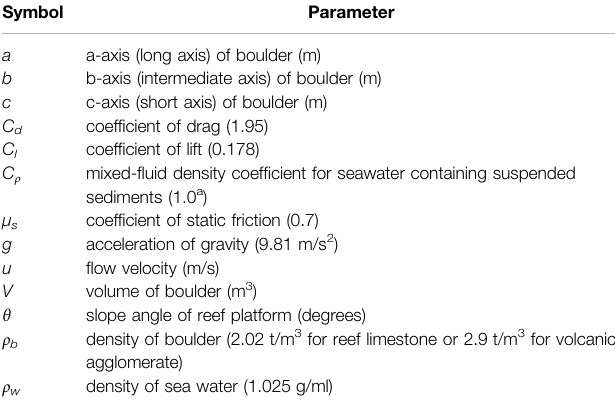
TABLE 1 | Parameters used in hydrodynamic fl ow transport equations. Symbol